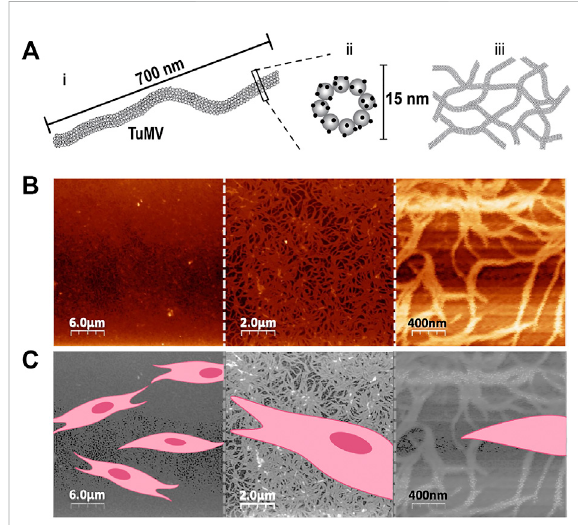
FIGURE 1 TuMV architecture and size. (A) Schematic representation of TuMV size and architecture. The TuMV capsidconsists of repeated protein units (shown as gray spheres) that contain lysine amino acid groups that can be chemically functionalized (shown as black dots). Schematic representation of aggregated TuMV forming a nanomesh. (B) AFM characterization of TuMV nanomeshes deposited on a silica substrate. (C) Schematic representation of the relative size of mammalian cells deposited on a TuMV nanomesh